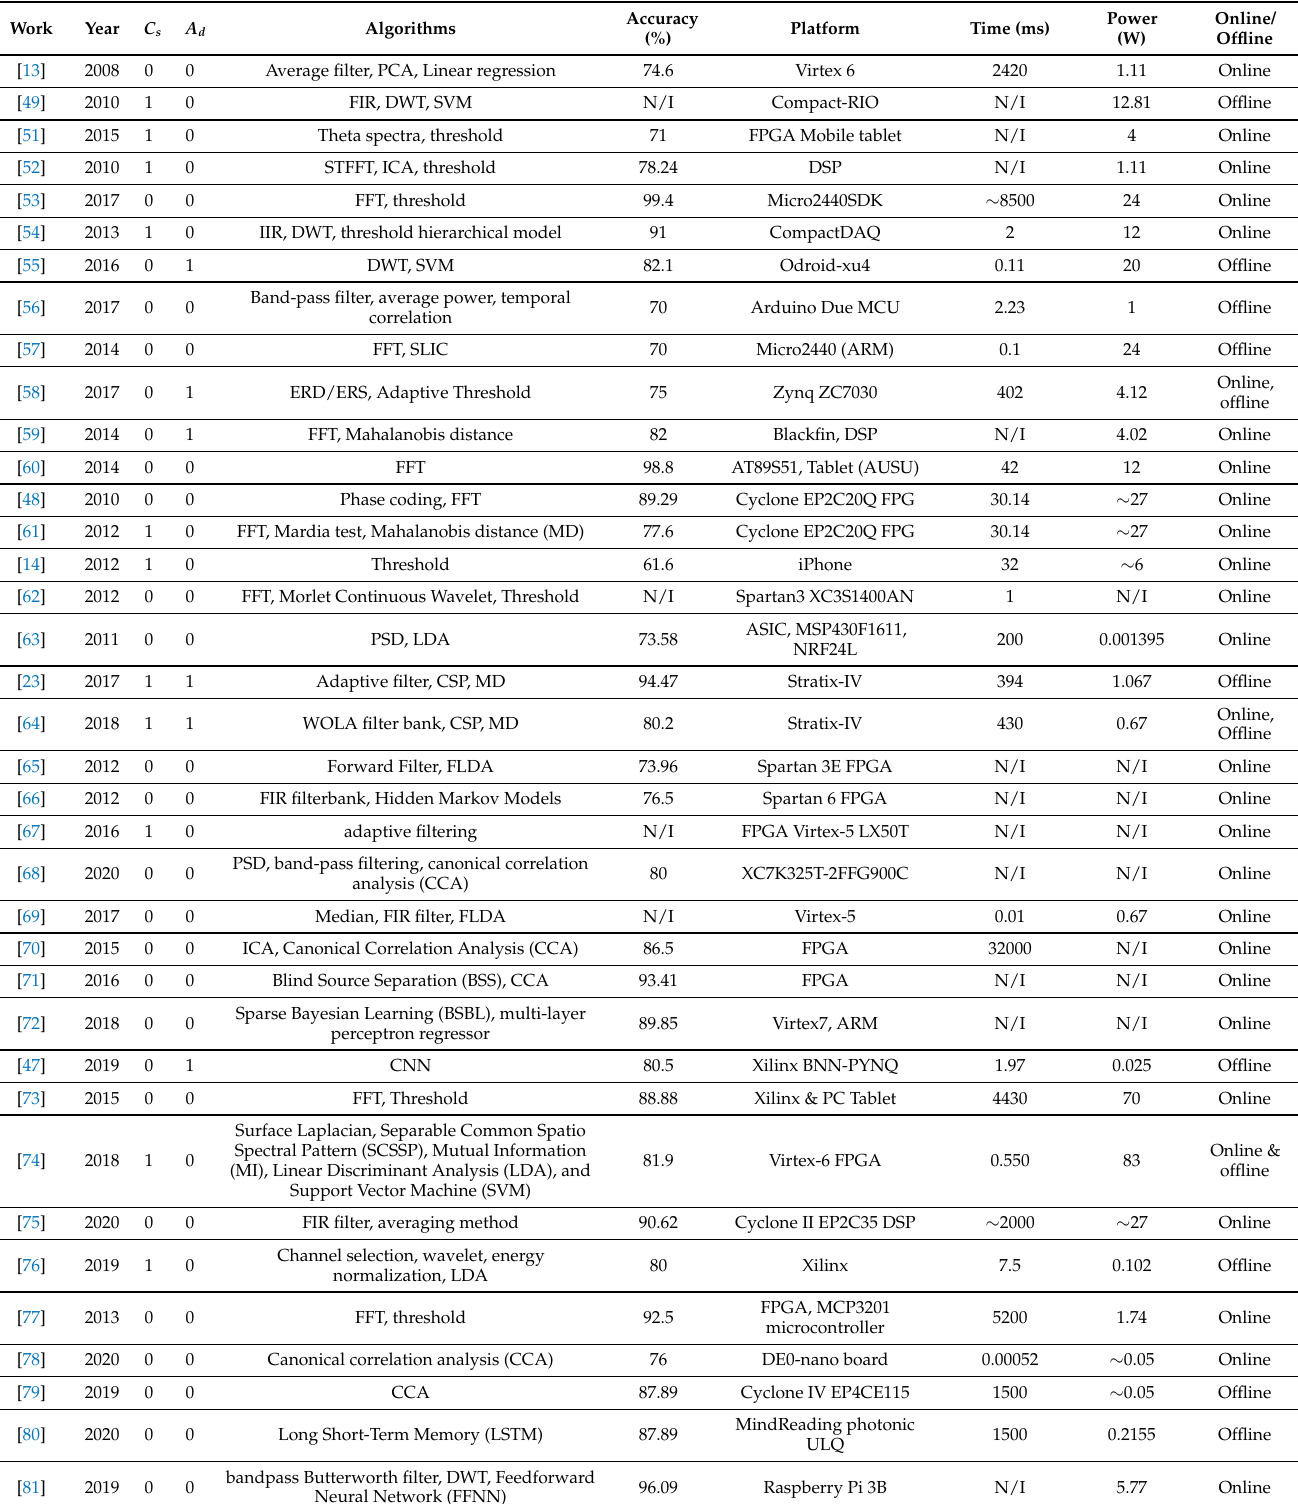
Table 3 resumes the existing EBCI systems, for functional substitution, in literature based on a research in PubMed, IEEExplore, ScienceDirect, and Google scholar research web engines. The existing systems are evaluated using the predefined criteria. Table 3. Summary of related works on embedded BCIs for functional substitution: N/I: No indication, 0: bad, 1:good.